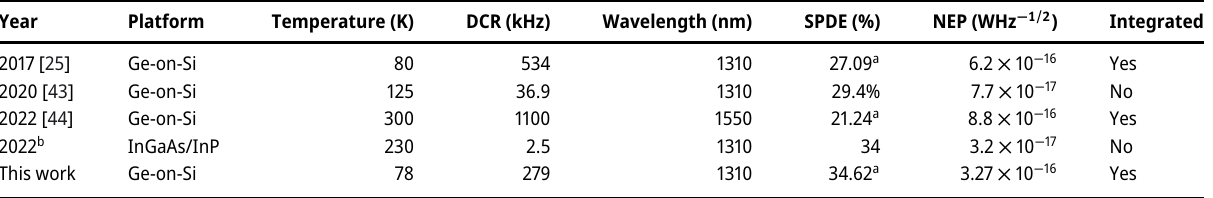
Table 1: State-of-the-art Ge-on-Si and InGaAs/InP SPADs.